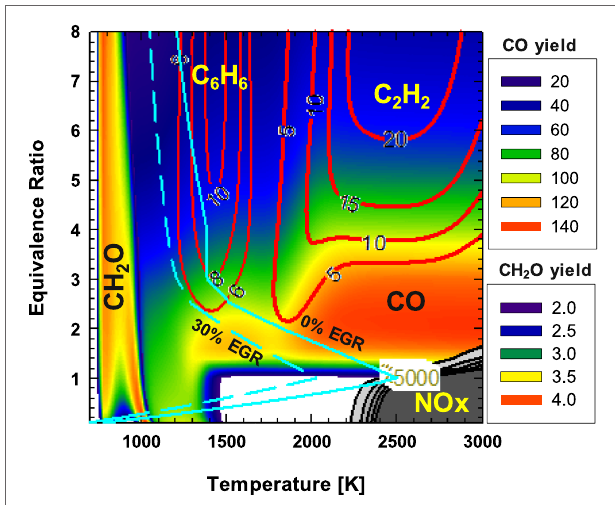
FigUre 1 | Emission of soot precursors including acetylene (C 2 H 2 ), benzene (C 6 H 6 ) in contour lines (soot yield), and other emission species (CH 2 O, CO) in color maps from homogeneous closed-reactor model (60 bar, 2.0 ms residence time) of TPRF gasoline surrogate and air (21% O 2 ). Unit of NO is in ppm.